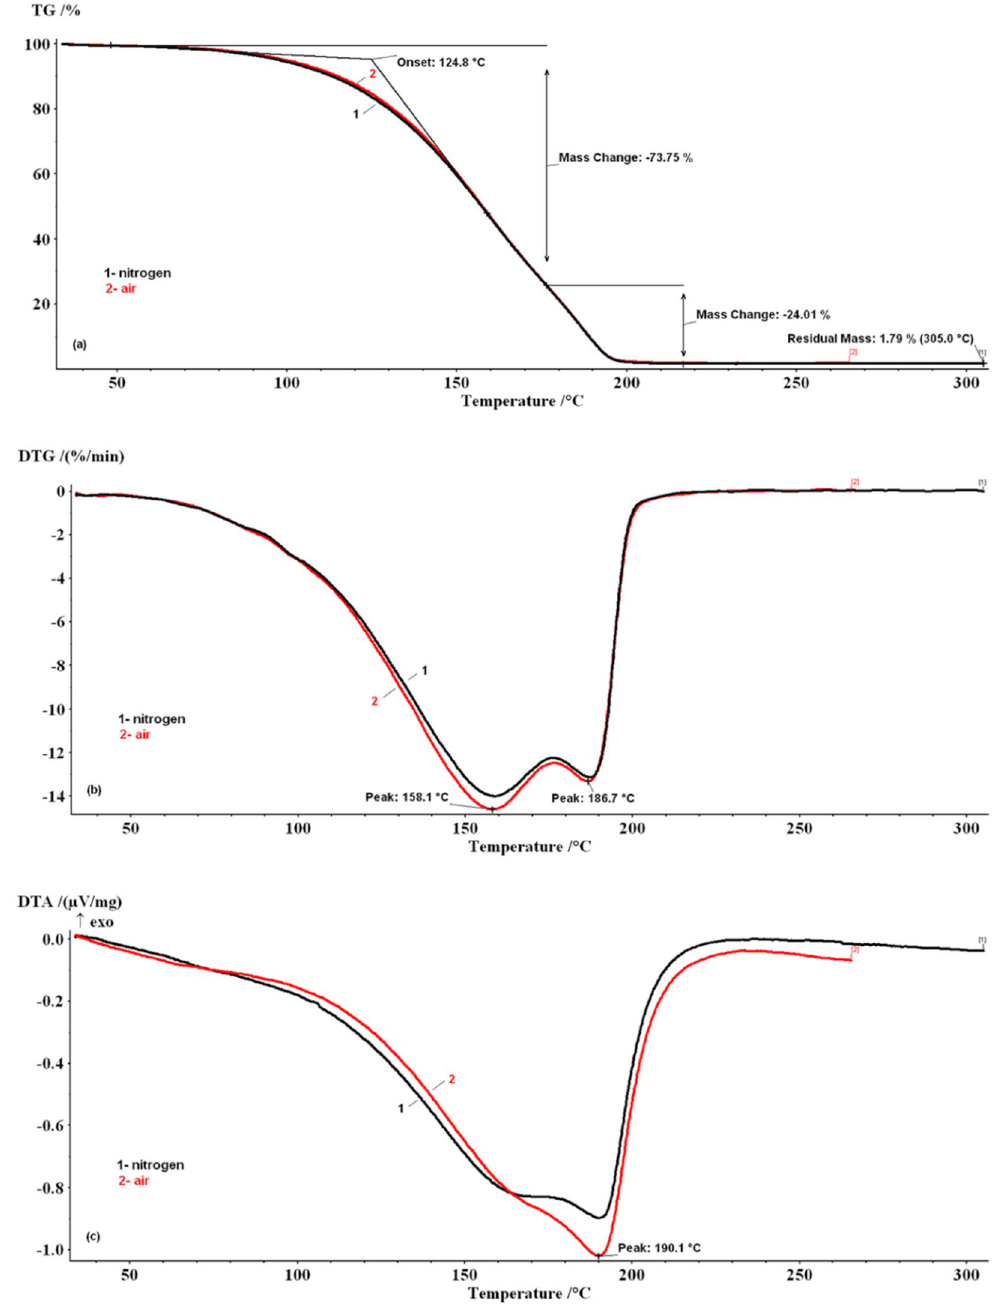
Figure 4. Thermo-analytical curves of SHEO in the nitrogen and air decomposition atmosphere. (a) TG curves; (b) DTG curves; (c) DTA